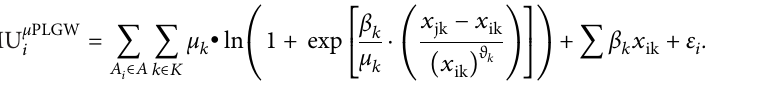
Figure 5: Origin (a) and destination (b) choice